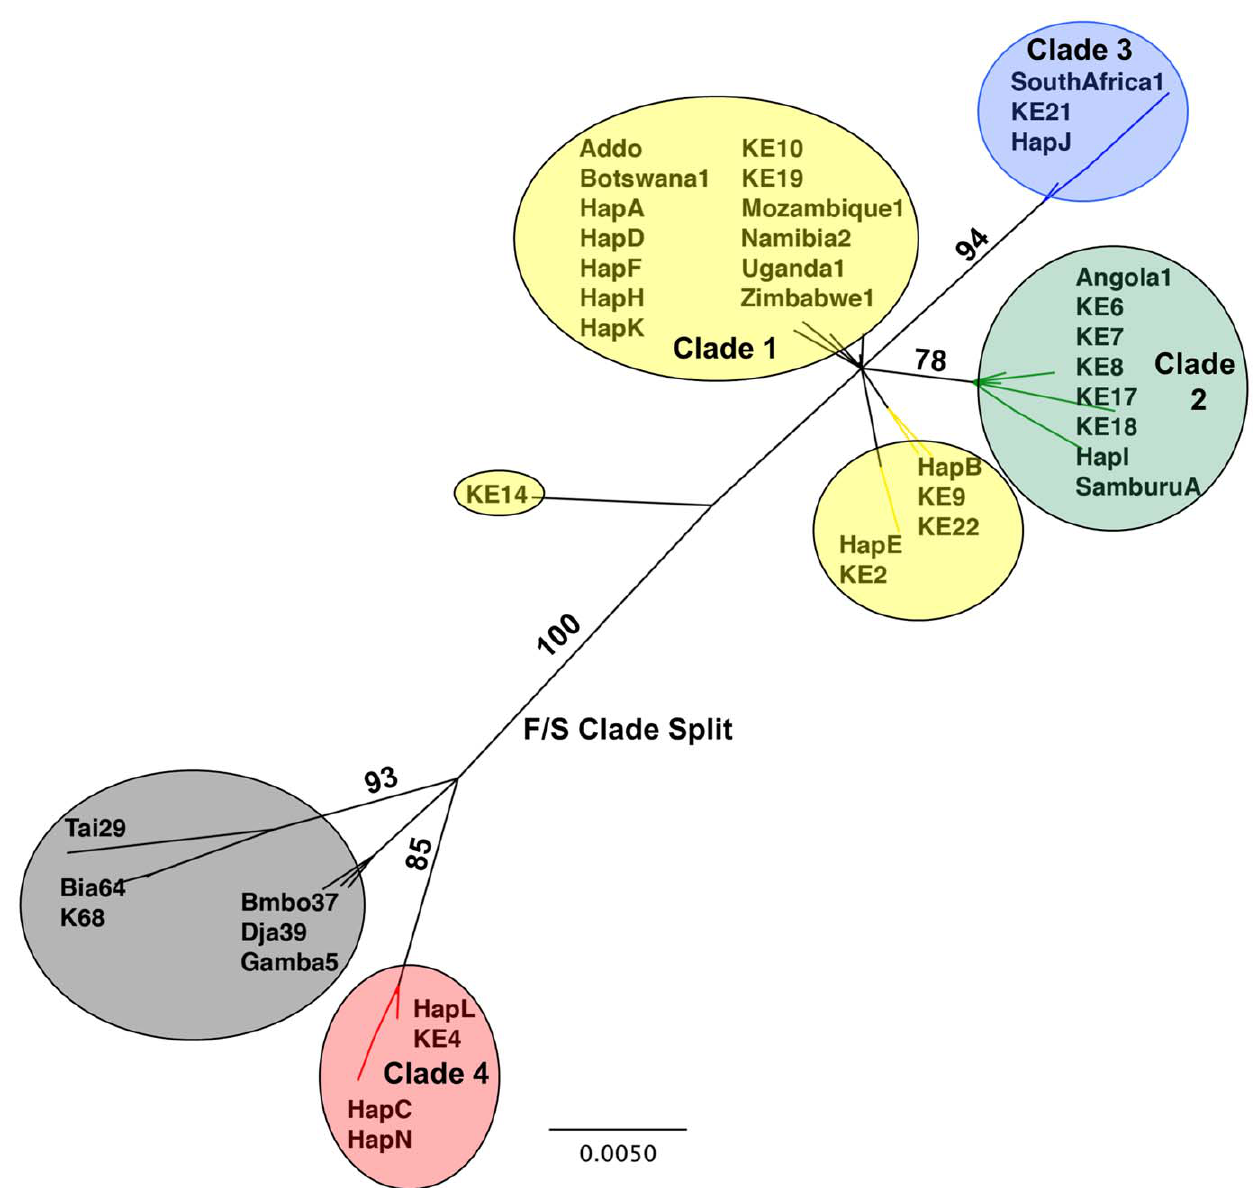
Figure 3. Neighbour-joining Tree for Savannah Elephant mtDNA Haplotypes. Unrooted neighbour-joinging tree using the HKY model in Geneious showing the relationship between 12 mtDNA haplotypes from elephants in Kenya and Tanzania and including published haplotypes in GenBank from Okello et al. [4], Eggert et al. [7] and Debruyne [17]; statistical support shown from 1000 bootstrap replicates. Clade nomenclature (Okello Clade 1–4) as denoted by Okello et al. [4] (yellow=Clade 1, green=Clade 2, blue=Clade 3, red=Clade 4, gray=Loxodonta cyclotis); F/S Split as denoted by Debruyne [17]. Hap A-F, H-L, and N represent the 12 haplotypes identified in this study.